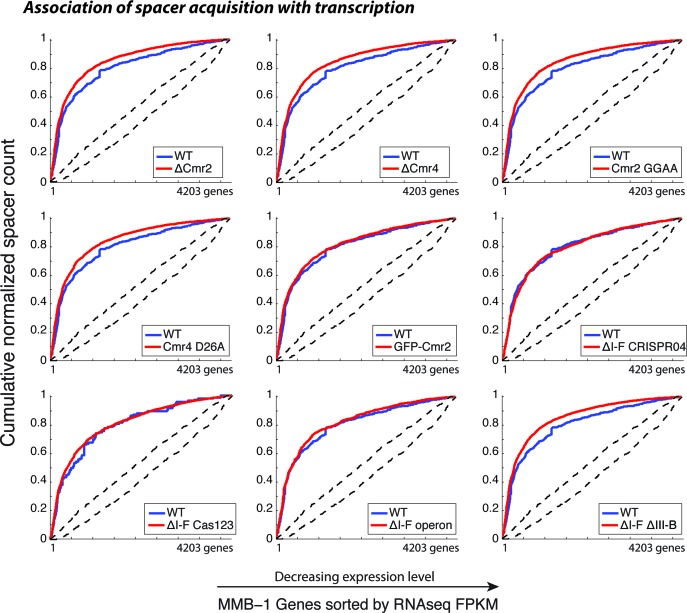
CRISPR spacer acquisition in M. mediterranea mutants.Cumulative normalized distribution of spacers in (A) among M. mediterranea genes sorted by RNAseq FPKM (fragments per kb per million reads), with genes ordered by decreasing expression level. Each dataset includes spacers from two separate transconjugants. Numbers of recovered spacers analyzed were as follows: 785 WT, 9311 ∆cmr2, 11963 ∆cmr4, 10727 Cmr2:GGAA, 6173 Cmr4:D26A, 3757 GFP-Cmr2, 4398 ∆I-F CRISPR04, 1599 ∆I-F operon, and 16517 ∆I-F∆III-B. The ∆I-F Cas123 mutant was tested in a separate experiment with 137 WT and 12845 ∆I-F Cas123 spacers recovered. Spacers acquired in the presence of WT RT-Cas1 (blue) show preferred acquisition from highly expressed genes, indicative of spacer acquisition from RNA, and are plotted in each panel for comparison. Dashed black lines show the range of values from a Monte-Carlo simulation with random assortment (no transcription-related bias).